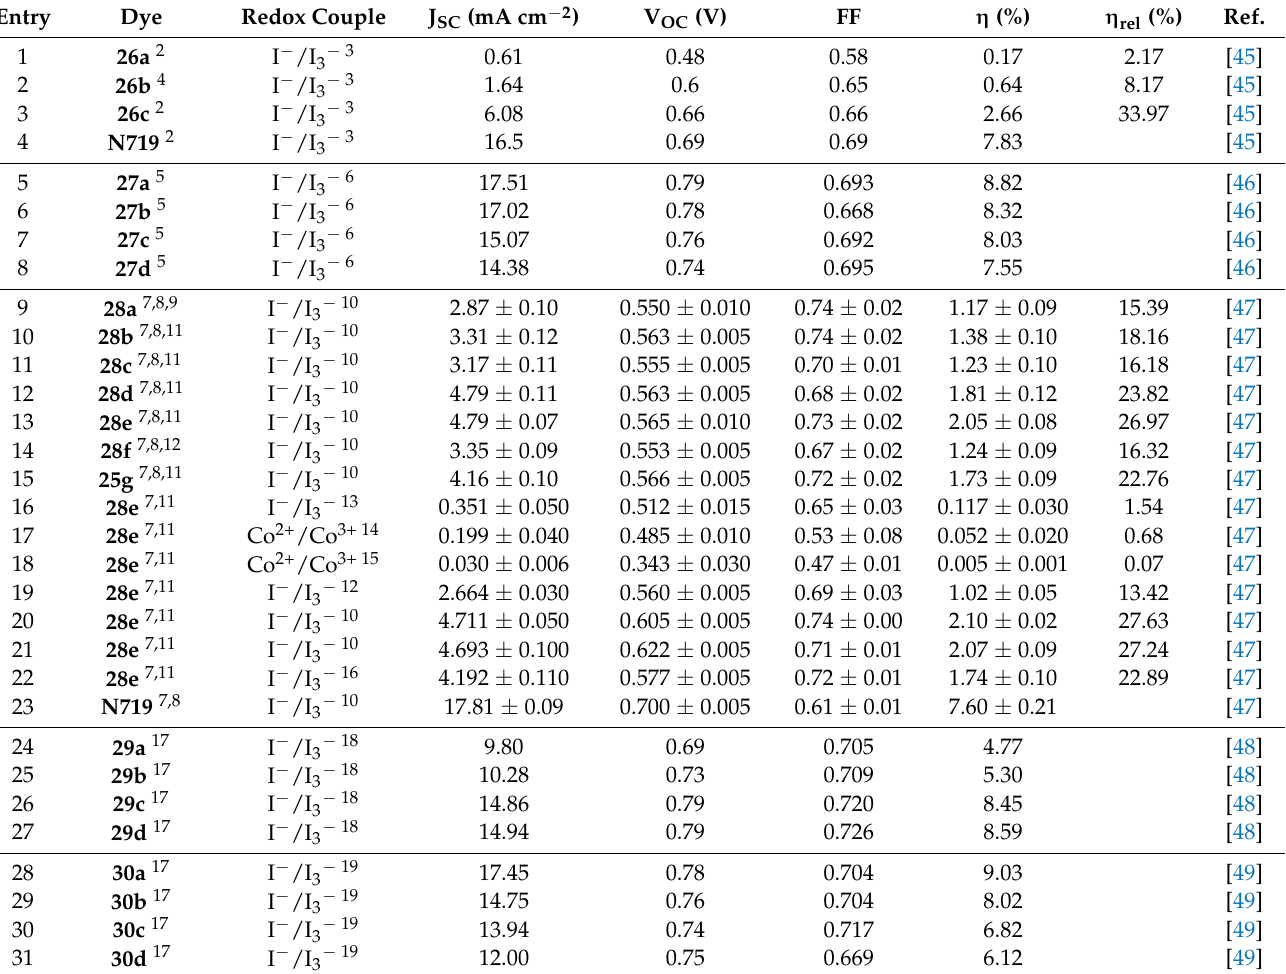
Table 6. Photovoltaic data of DSSCs produced with dyes 26a – c , 27a – d , 28a – g , 29a – d , and 30a – d 1